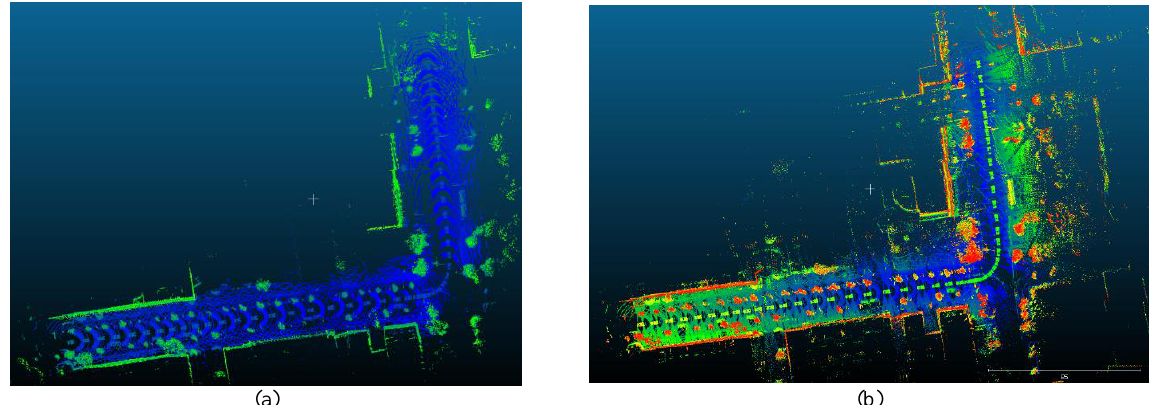
Figure 10. A sample from the georeferenced HDL-32E data (a), and all LiDAR sensors’ data combined (b); points with 5 m above the road surface are removed, height is